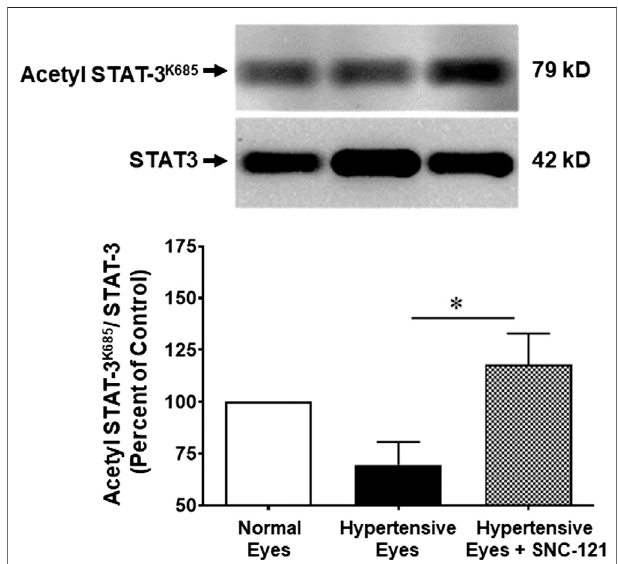
FIGURE 6 | Changes in STAT3 acetylation at lysine 685 (AcK685) in response to ocular hypertension and SNC-121 treatment. The retina from normal, ocular hypertensive, and SNC-121 treated ocular hypertensive animals were collected at day 7, post hypertonic saline injection. Equivalentamountofretinaproteinextracts(20 μ g)wereanalyzedbyWestern blotting using a selective anti-Acetyl STAT3 (AcK685) or anti- β -actin antibodies. The band intensities were measured using enhanced chemiluminescence reagent and Versadoc imaging system. Bar graph represents mean data ± SEM. OH Eyes; ocular hypertensive eyes; OH Eyes + SNC-121,ocularhypertensiveeyeswithSNC-121treatment.* p < 0.05. n (cid:2) 6, In this experiment “ n ” represent a biological